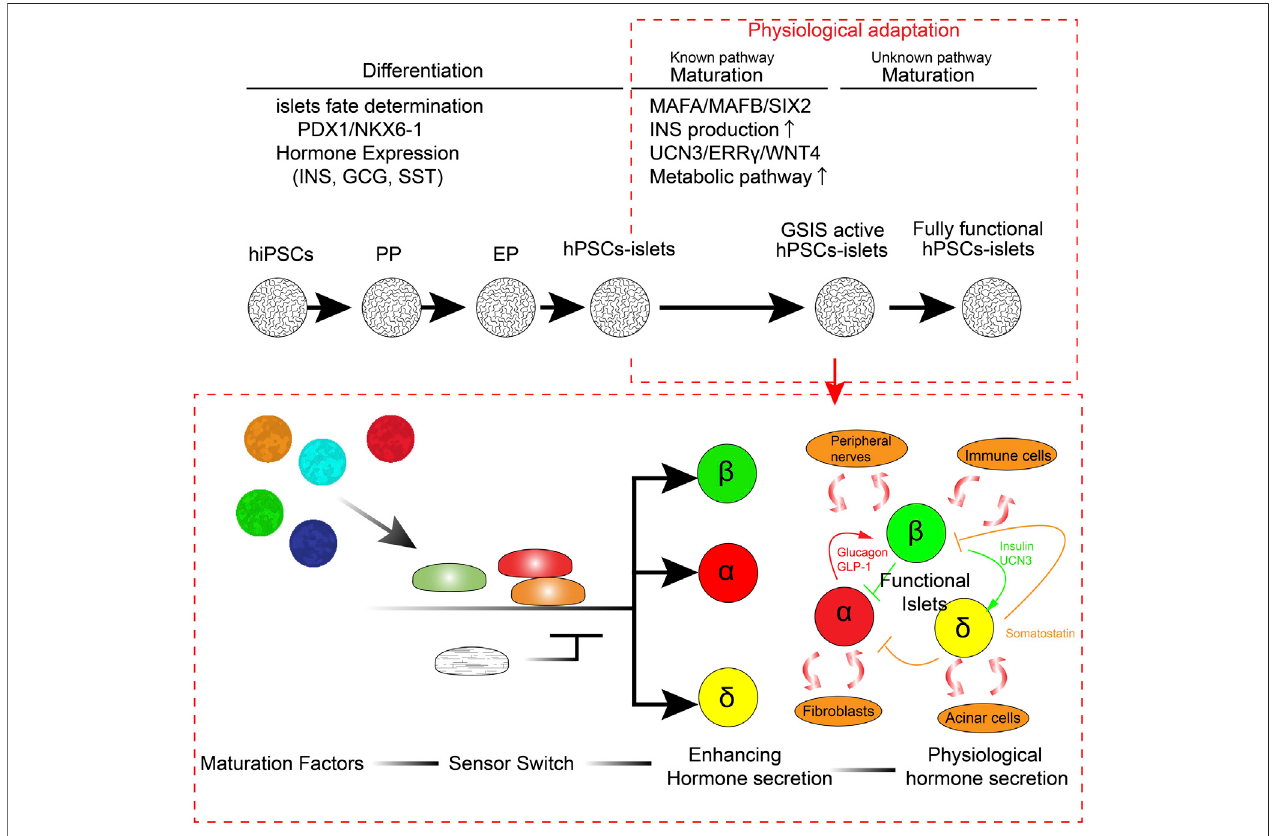
FIGURE 1 | Stepwise physiological adaptation in functional human islet